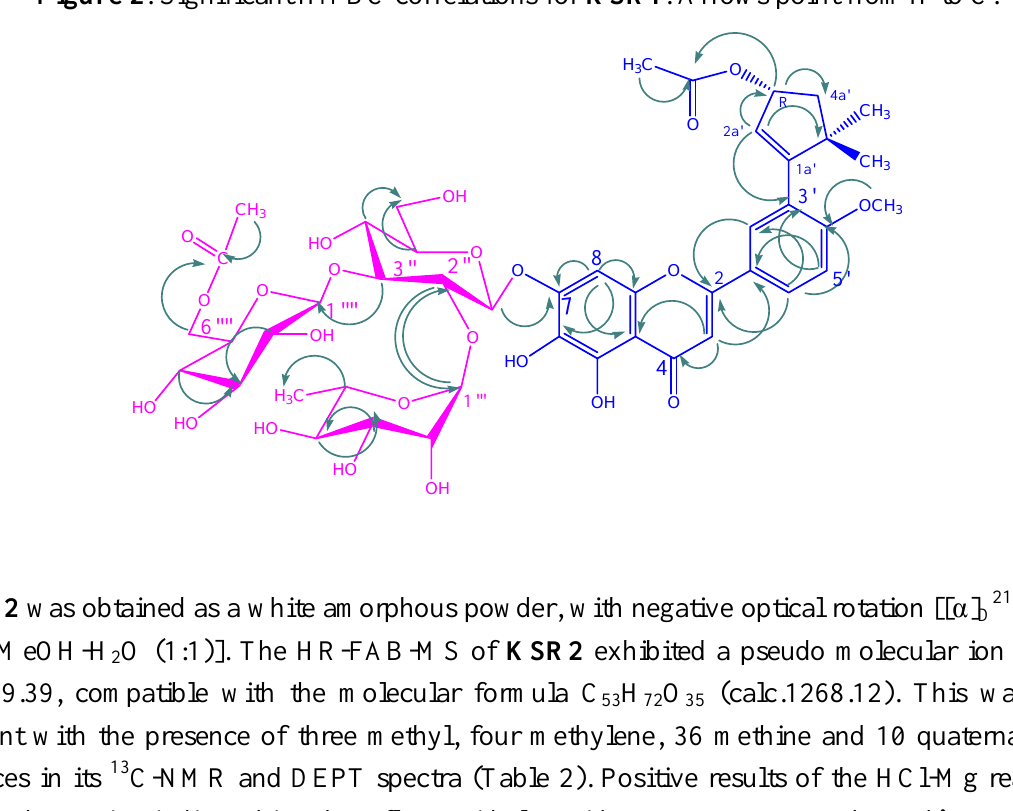
Figure 2 . Significant HMBC correlations for KSR1 . Arrows point from H to